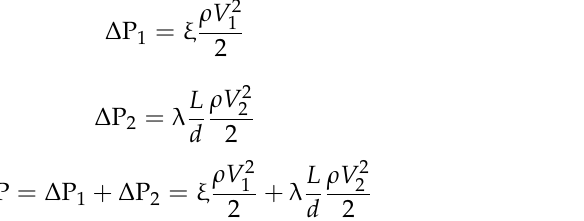
Figure 3. The displacement of variable displacement pumps is controlled by paralleling the five-cylinder piston rods controlled by pilot pressure. The displacement of variable displacement pumps is comprehensively controlled according to the flow required by the boom cylinder, stick cylinder, bucket cylinder, travel motor, and swing motor. This system does not need to compare the pilot pressure through the shuttle valve, and the system structure is simple. The flow required under the same working conditions is reduced by 26.2%, with good flow matching accuracy and power utilization.